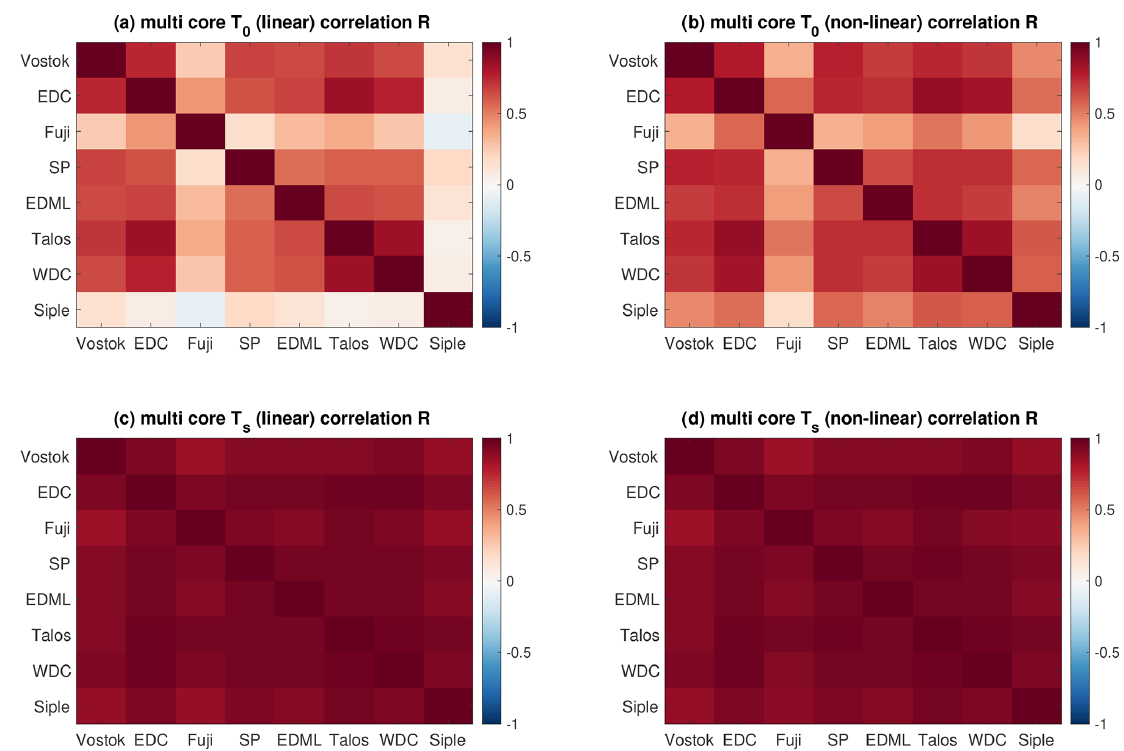
Figure A21. Correlation ( R ) matrices for temperature reconstructions of all core sites. (a) Correlation among reconstructions of T 0 using a linearization of SWIM results for isotopic conditions of the Holocene. (b) Correlation among reconstructions of T 0 using the full nonlinear SWIM results. (c) Correlation among reconstructions of T s using a linearization of SWIM results for isotopic conditions of the Holocene. (d) Correlation among reconstructions of T s using the full nonlinear SWIM results. All records are ordered by their approximate modern surface temperature.